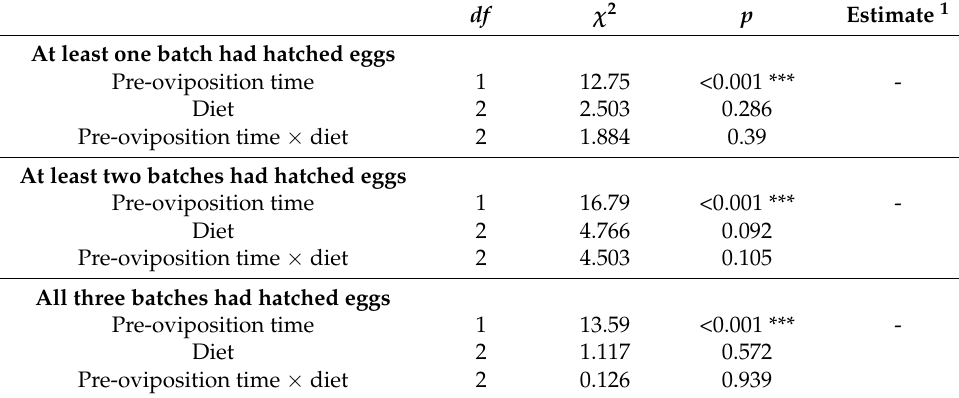
Table 2. Effect of pre-oviposition time, diet (flowers, prey, or starving), and their interaction on the rate of viable egg batches (degree of freedom ( df ), chi-square value ( χ 2 ) and p -value ( p ) from the likelihood-test for generalized linear models (GLM) are provided, *** p < 0.001). df χ 2